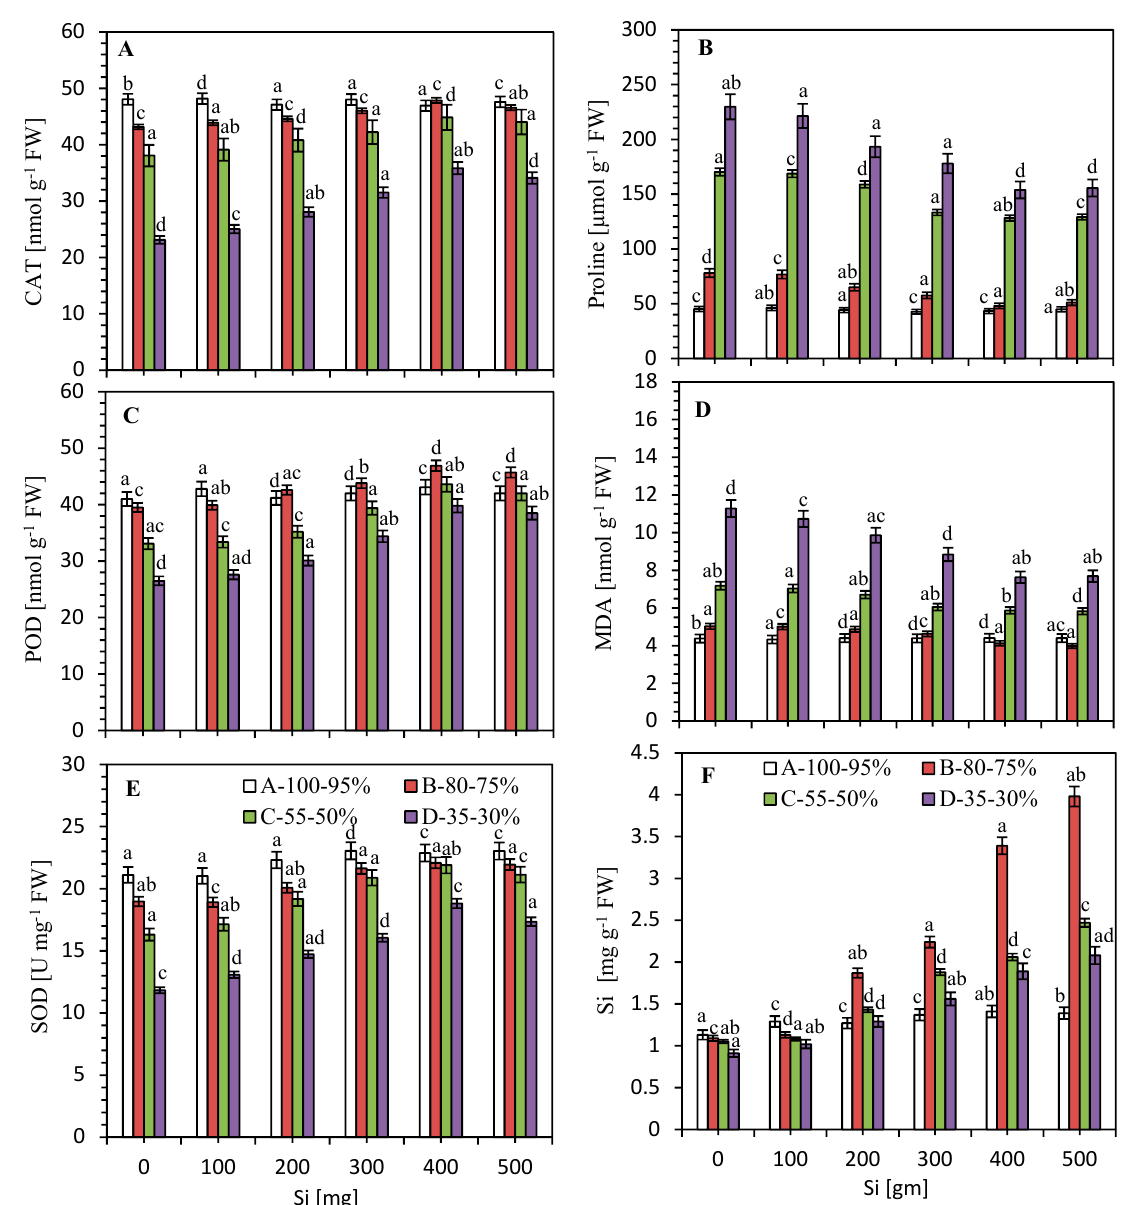
Figure 3. Effect of antioxidant enzymatic activities such as ( A ) catalase (CAT; nmol g − 1 FW), ( C ) peroxidase (POD; nmol g − 1 FW), ( E ) superoxide dismutase (SOD; unit mg − 1 FW) and non-enzymatic activities, i.e., ( B ) proline content ( µ mol g − 1 FW), ( D ) malondialdehyde content (MDA; nmol g − 1 FW), and ( F ) silicon content (Si; mg g − 1 FW) in sugarcane leaves on day 60 after normal and limited irrigation with silicon application (0, 100, 200, 300, 400 and 500 mg l − 1 ). Vertical bars represent ± standard errors ( n = 5).